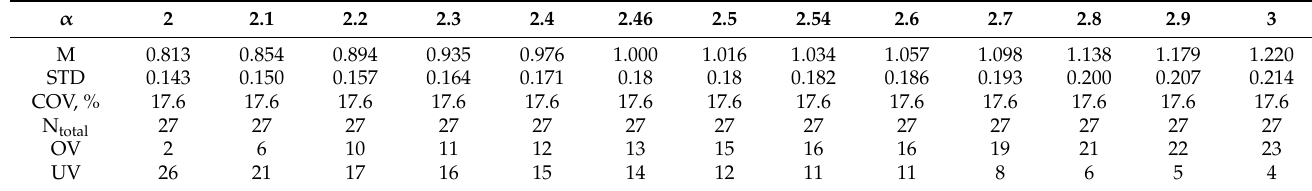
Table A6. The influence of α on the statistical results of L t.teor /L t.exp of CFRP bars.